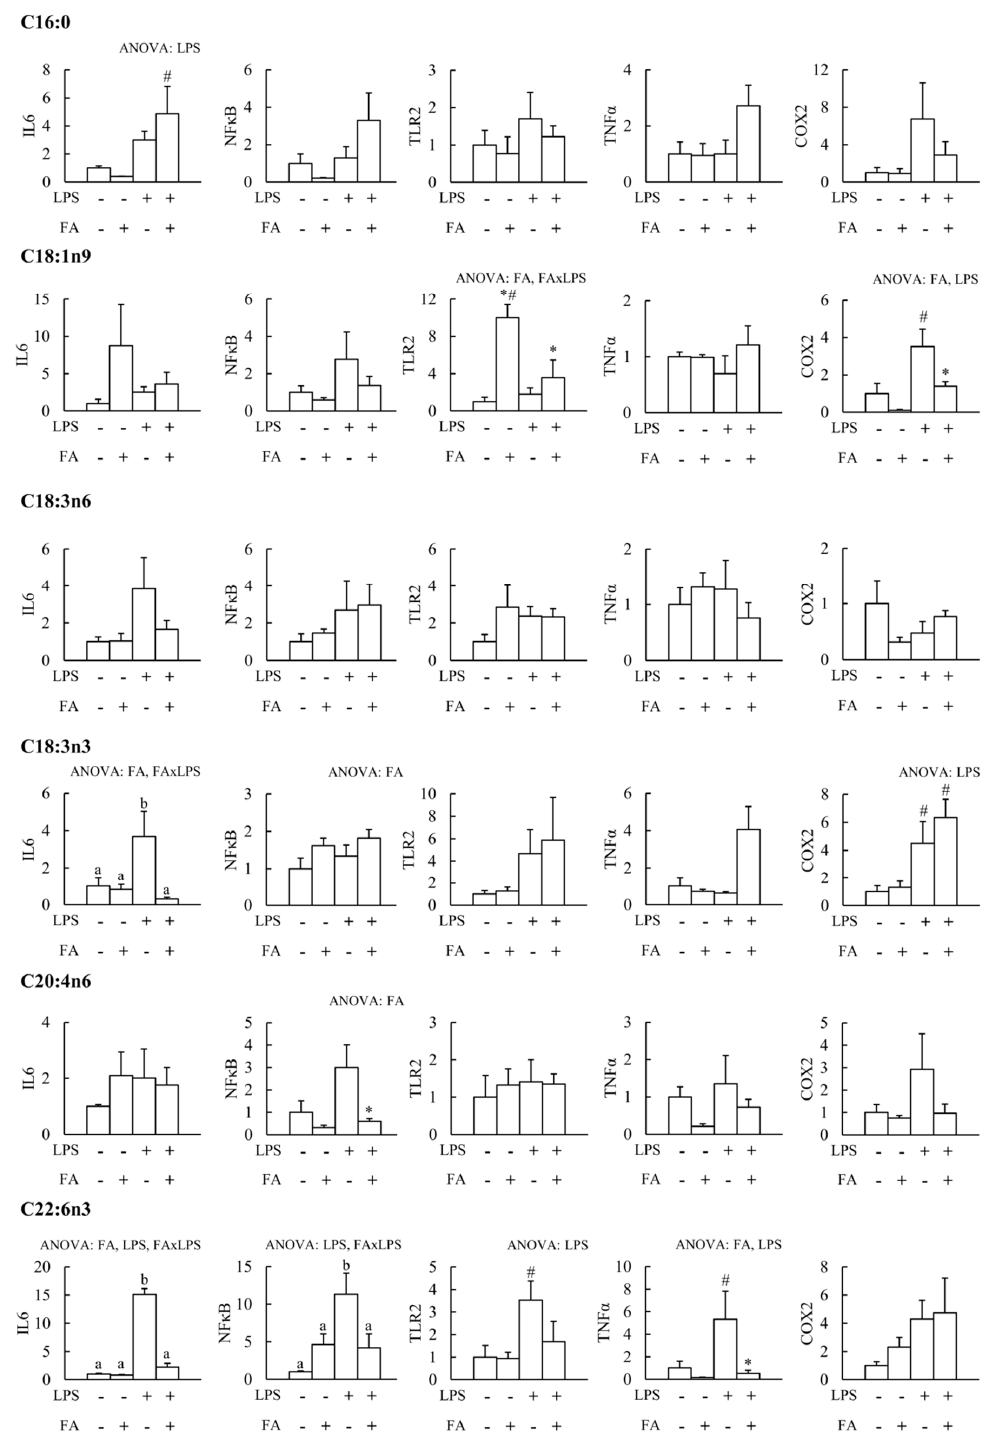
Figure 1. E ff ect of fatty acids (FA) and lipopolysaccharide (LPS) on peripheral blood mononuclear cells’ (PBMCs) anti- / proinflammatory gene expression. ANOVA: FA, LPS, or FA / LPS indicates significant di ff erences (p < 0.05) by e ff ect of fatty acids (FA), lipopolysaccharide (LPS), or interaction (FA / LPS) by two-way ANOVA. * Significant di ff erences ( p < 0.05) between FA − and FA + ; # Significant di ff erences ( p < 0.05) between LPS − and LPS + by one-way ANOVA. Di ff erent letters indicate significant di ff erences by one-way ANOVA. IL6: Interleukin 6; NF κ B: Nuclear factor kappa B; TLR2: Toll-like receptor 2; TNF α : Tumor necrosis factor α ; COX2: Cyclooxygenase